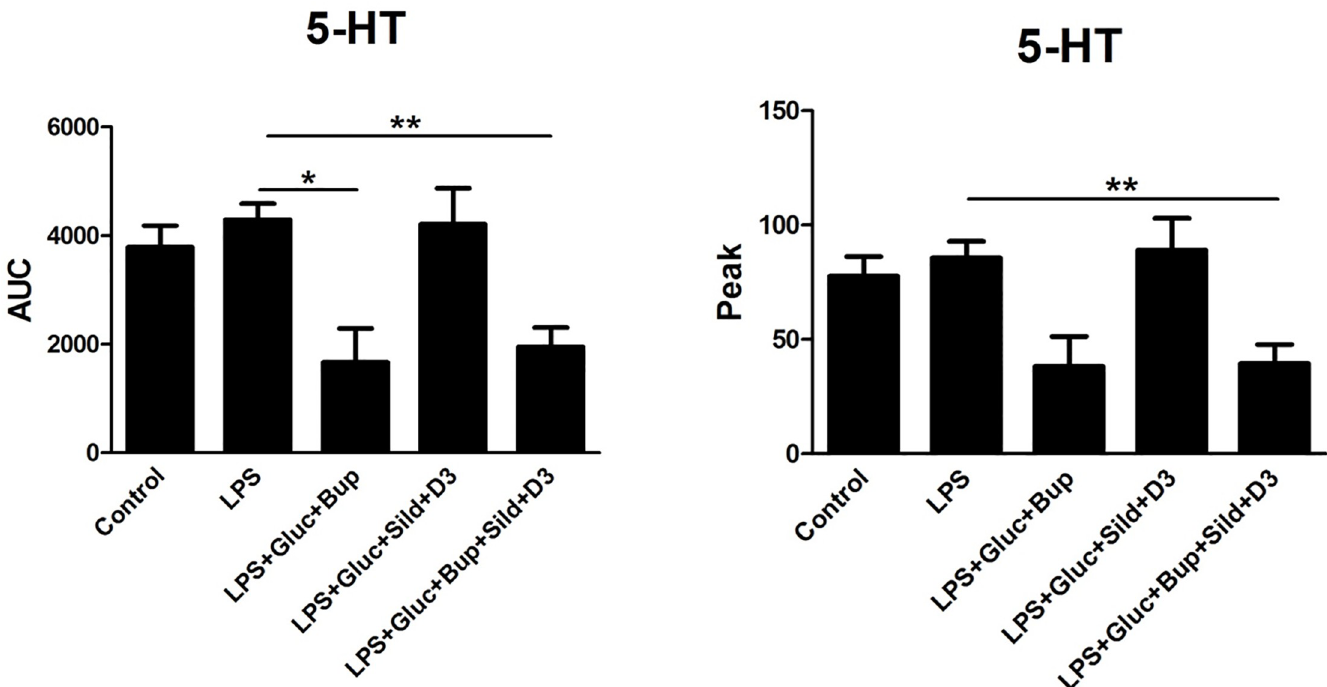
Fig 1. Astrocytes were incubated with the Ca 2+ -sensitive probe FLIPR Calcium 6. 5-HT (10 − 5 M) was used as a stimulator to detect changes in intracellular Ca 2+ release. The cells were cultivated in 5.5 mM glucose for the entire cultivation period. Ca 2+ responses were measured after the cells were stimulated with 5-HT (control), incubated with LPS (10 ng/ml) for 24 h, or incubated with LPS for 24 h followed by LPS, 25 mM glucose + bupivacaine (Bup) (10 − 12 M), 25 mM glucose + sildenafil (Sild) (1 μ M) + vitamin D3 (D3) (100 nM), or a combination of all substances for an additional 24 h. The area under the curve (AUC) of the Ca 2+ peak was calculated for each Ca 2+ transient, and the amplitude (peak) was expressed as the maximum increase. The cells were obtained from 4 experiments with quadruple wells in each. The level of significance was calculated against LPS and was analyzed using a one-way ANOVA followed by Dunnett’s multiple comparisons test. � P < 0.05, �� P < 0.01.